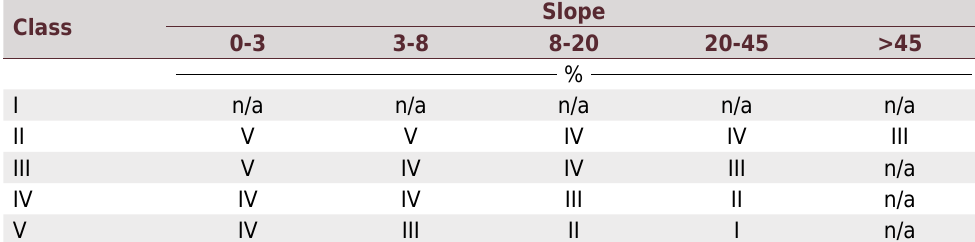
Table 5. Classes of susceptibility to linear erosion in the municipality of São Miguel do Araguaia, state of Goiás, Brazil